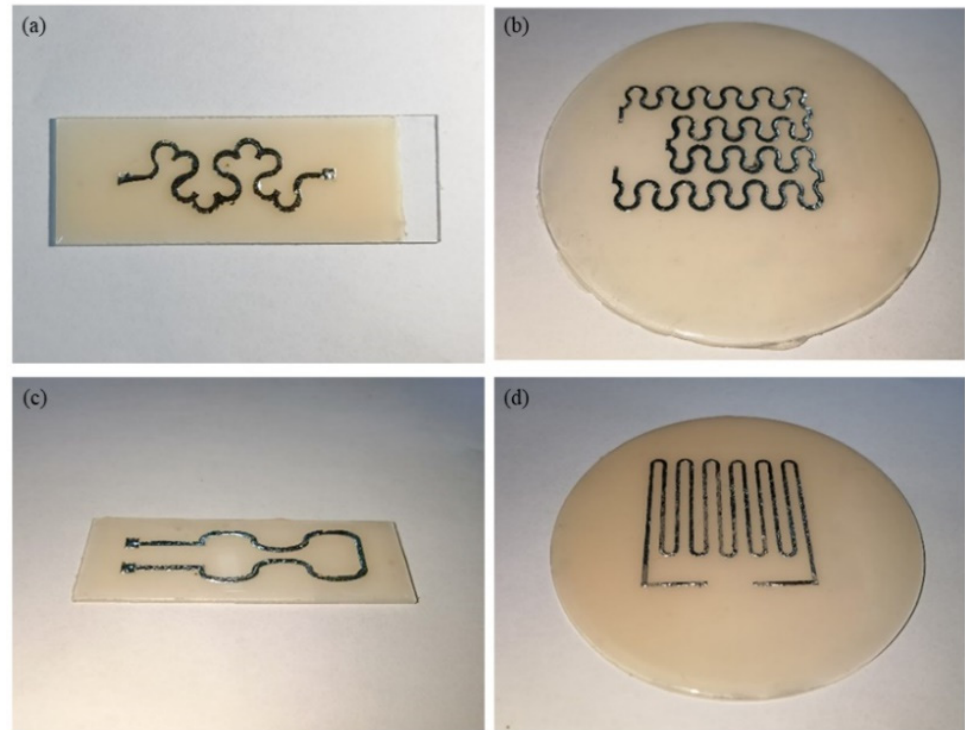
Figure 3. Circuit patterns of strain sensor in different wavy structures: ( a ) shamrock; ( b ) serpentine; ( c ) streamline; ( d ) periodic U shape.